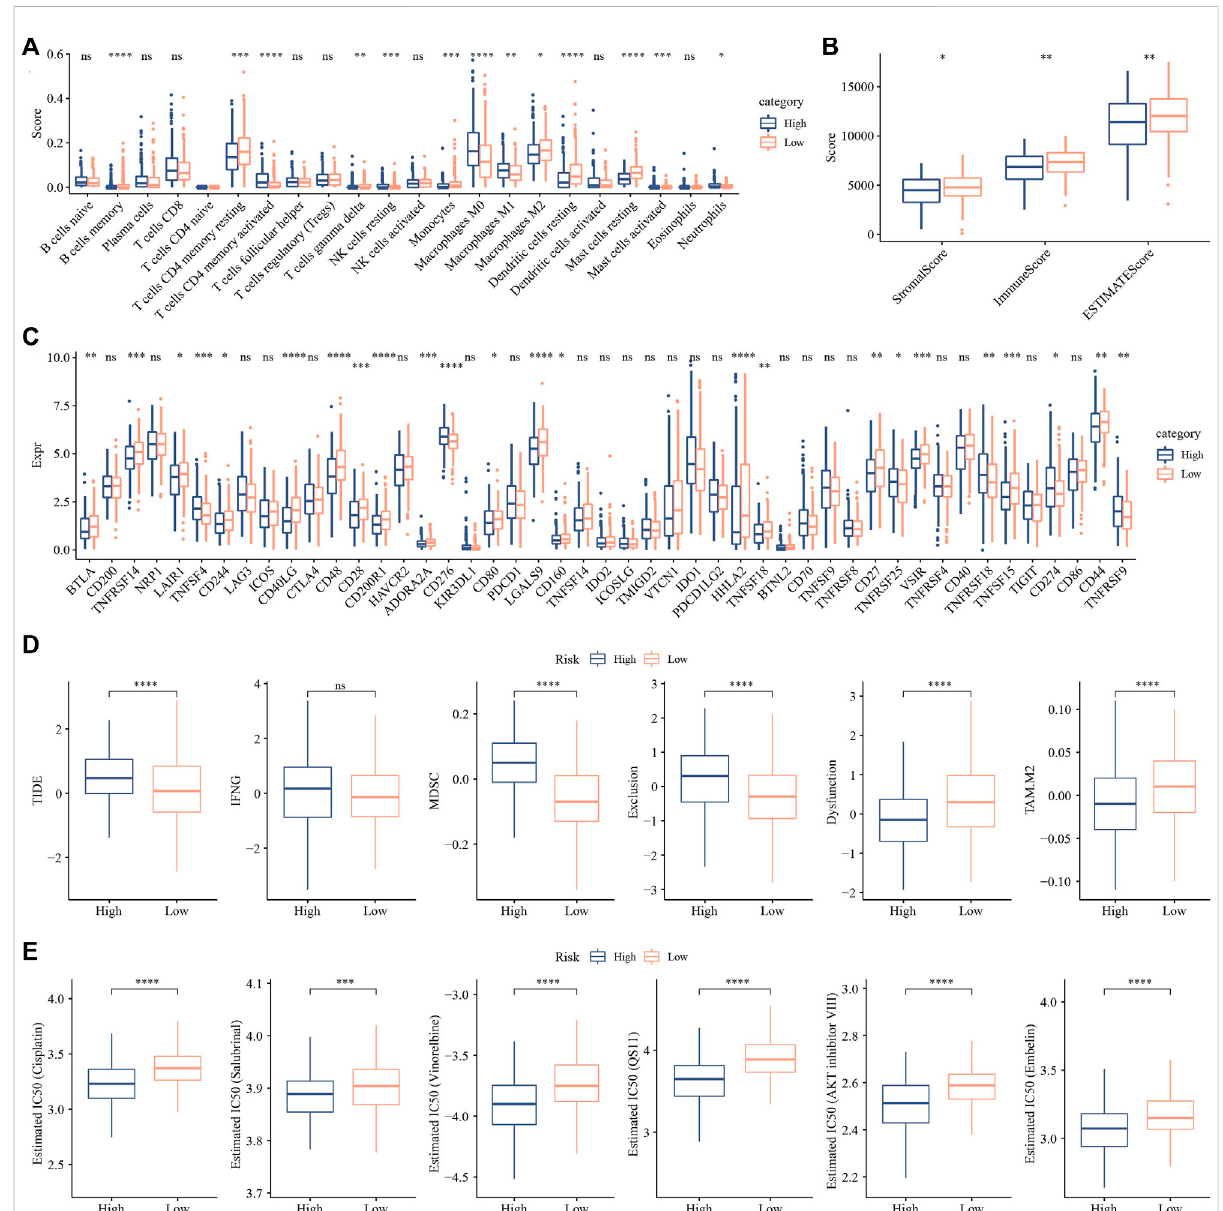
FIGURE 11 Analysis of immune in fi ltration. (A) analysis of 22 immune cells using CIBERSORT. (B) Analysis of immune in fi ltration using ESTIMATE. (C) The expression levels of 42 immune check genes between low group and high group. (D) The differences of TIDE, IFNG, MDSC, Exclusion, Dysfunction andTAM.M2 betweenlow groupand highgroup. (E) IC50oftraditionaldrugs inlowgroupand highgroup. * p < 0.05, ** p < 0.01,*** p < 0.001, *** p < 0.0001, ns: no signi fi